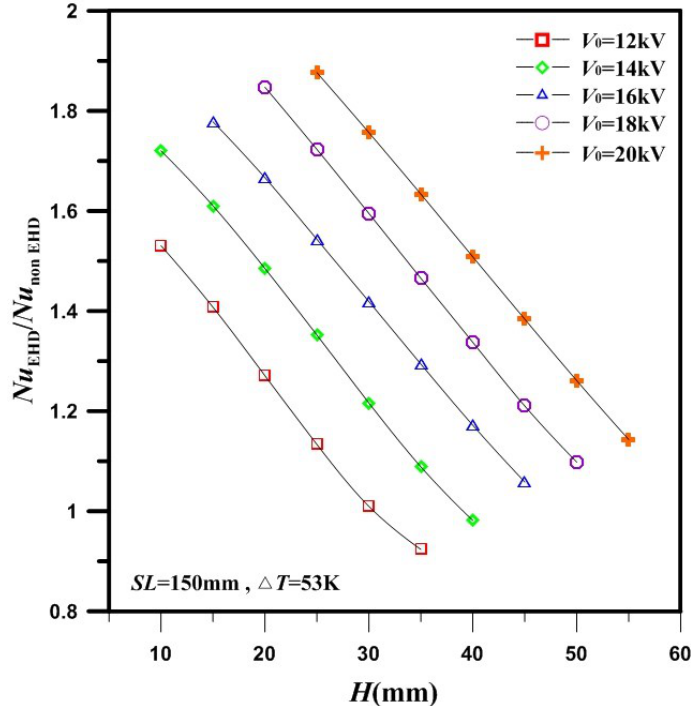
Figure 10. Variations in Nu EHD / Nu nonEHD versus electrode heights H for different applied voltages V 0 ( SL = 150 mm and Δ T = 53 K).